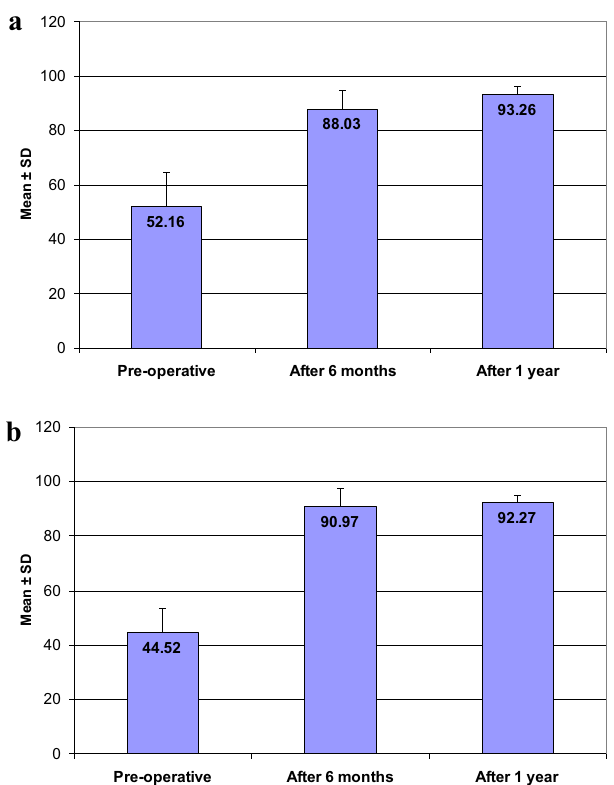
Figure 4. ( a) Tegner Lysholm knee score. (b) IKDC score.